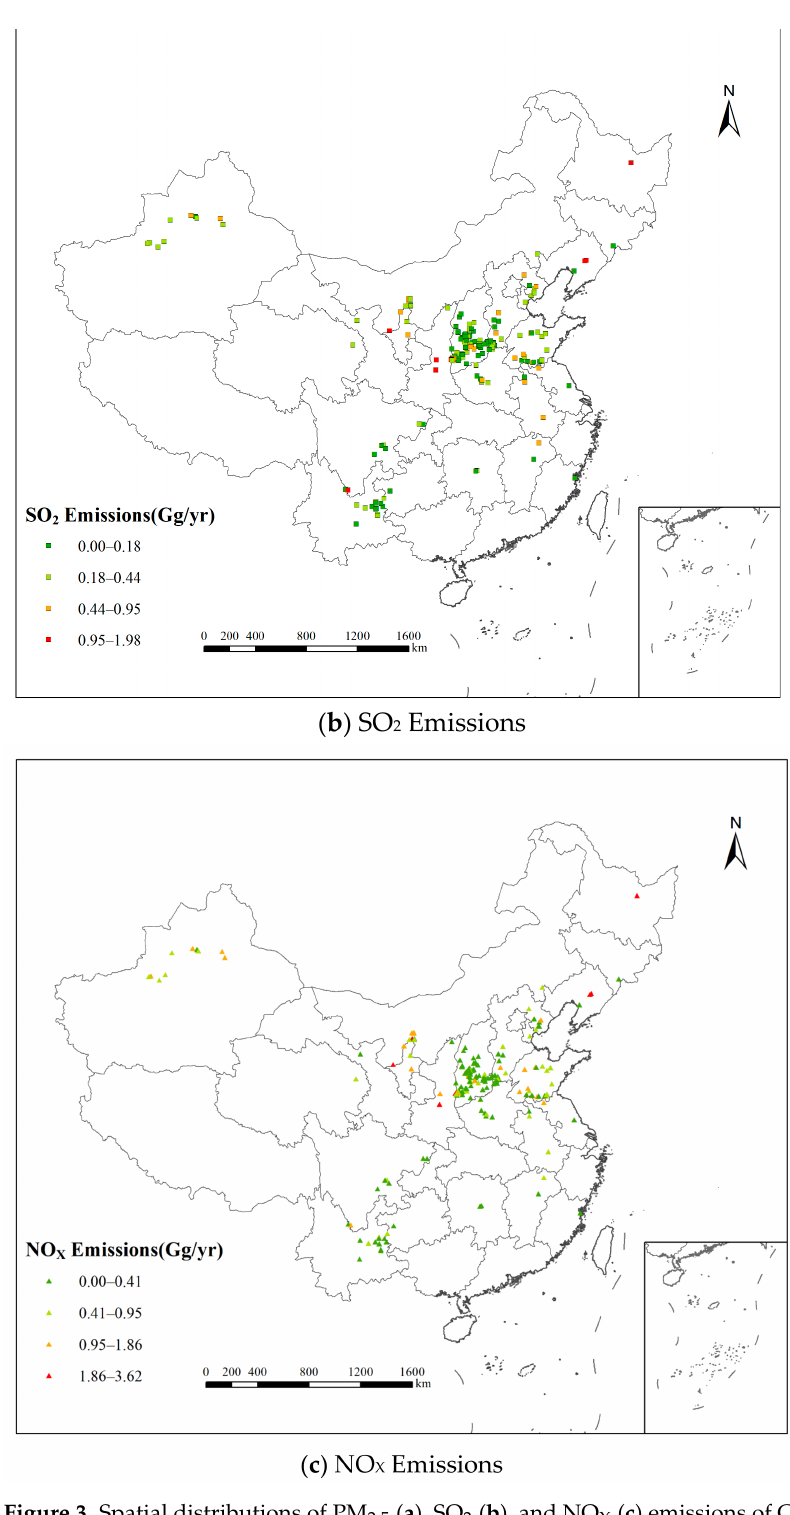
Figure 3. Spatial distributions of PM 2.5 ( a ), SO 2 ( b ), and NO X ( c ) emissions of China’s independent coking industry in